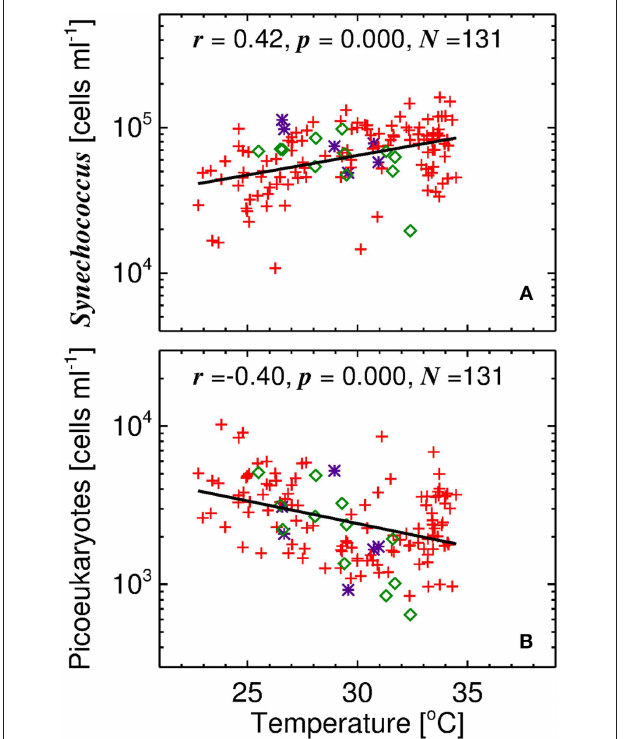
FIGURE 6 | Relationship between temperature and picophytoplankton cell counts. (A) Synechococcus vs. temperature and (B) Picoeukaryotes vs. temperature. Solid line is a linear regression and symbols follow those of Figures 1 , 2 .